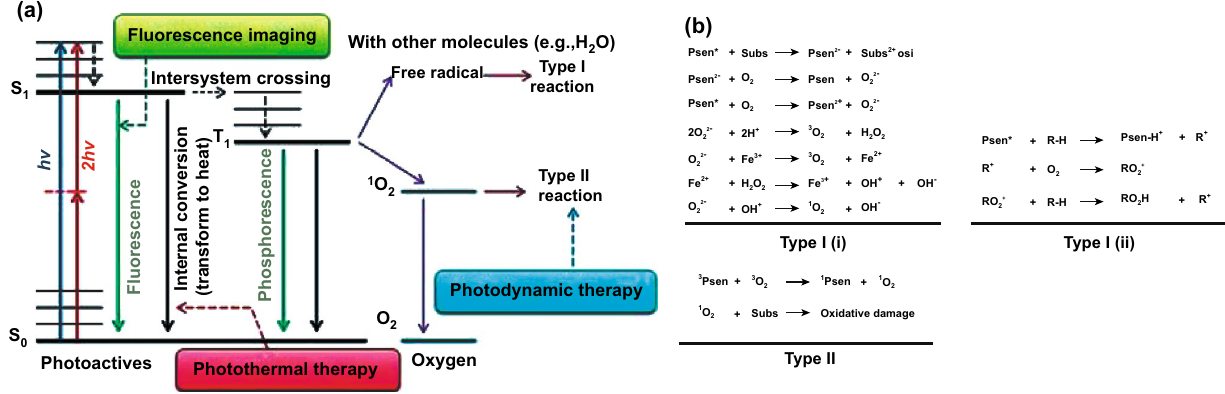
Fig. 1 a Simplified Jablonski diagram for photosensitizer molecule, reproduced from Ref. [29] with permission from Wiley Online Library. b Possible interactions of photosensitizer molecule with surrounding molecules via different types of reactions (Type I and II), reproduced from Ref. [30] with permission from